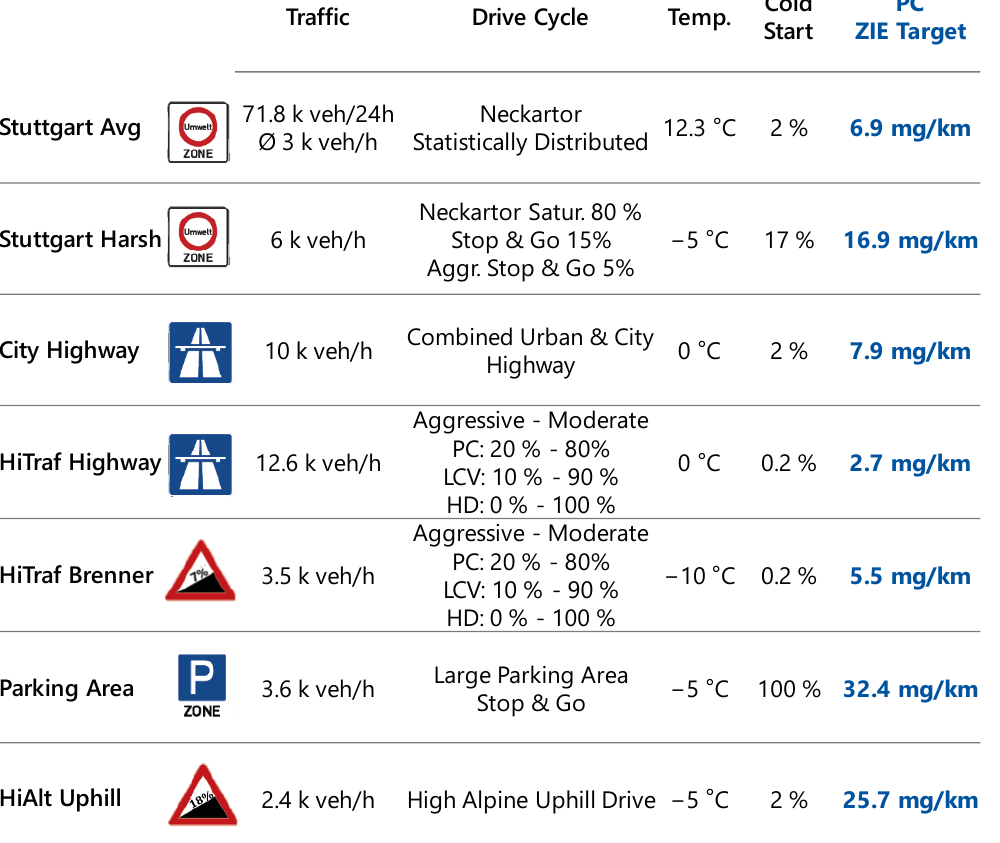
Figure 7. Zero-Impact Emissions test matrix with individual boundary conditions and targets for passenger cars (blue